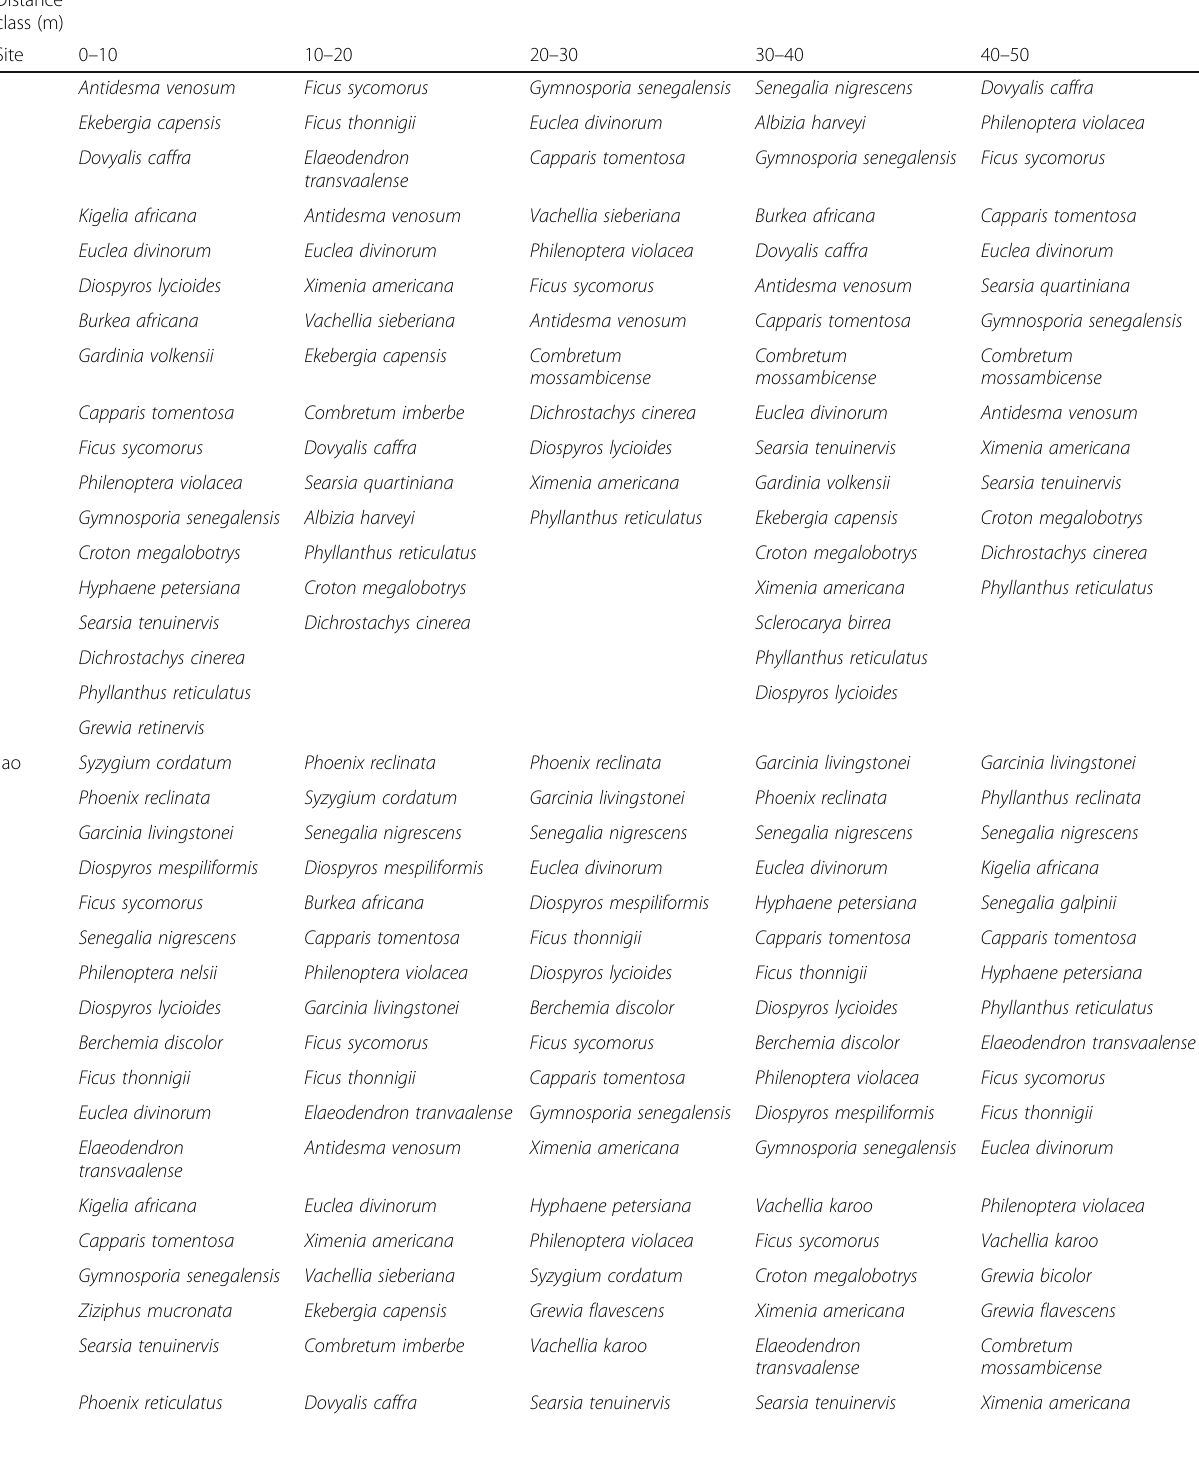
Table 2 Variation in composition of riparian woodland species at each distance class